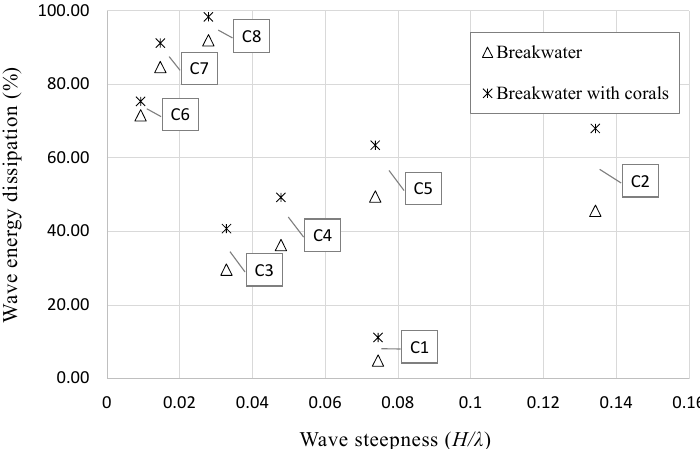
Figure 7. Wave-energy dissipation for the two configurations of the reef model under a water depth h = 0.55m.